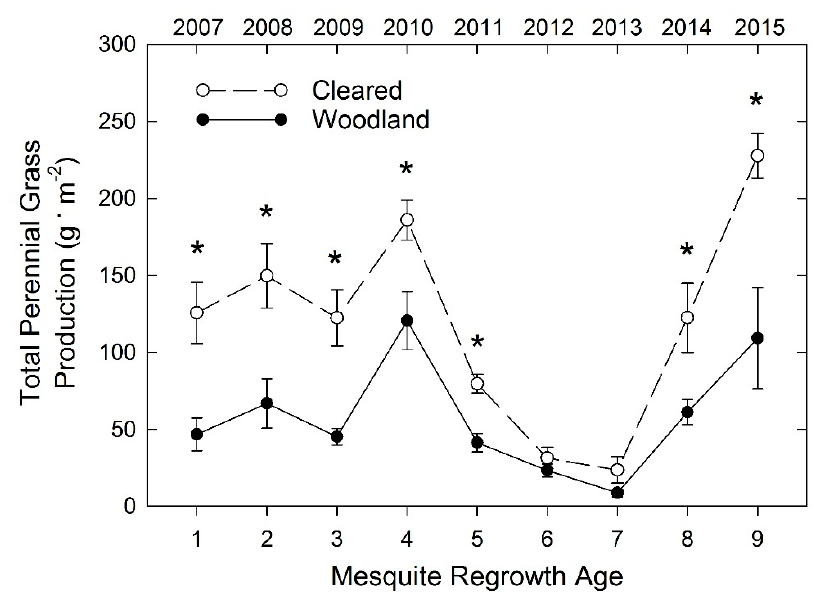
Figure 8. Total perennial grass (TPG) production, 2007–2015. Vertical bars on each mean indicate ± 1 standard error (n = 4). Means with an asterisk above are significantly different at p ≤ 0.05.